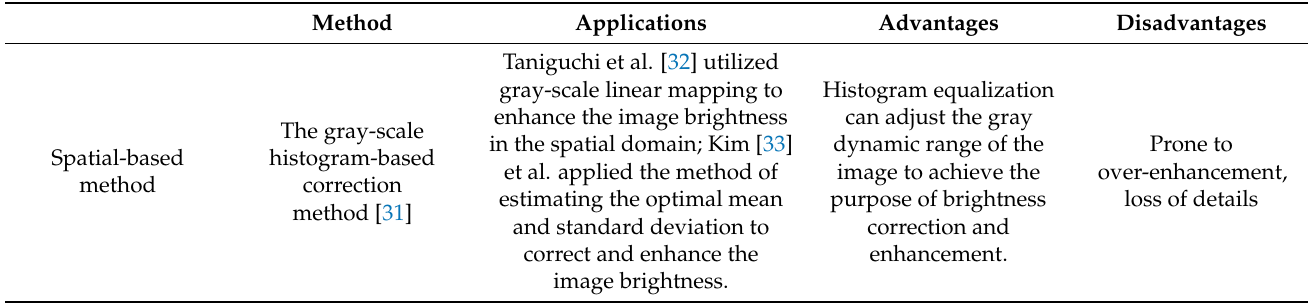
Table 3. Methods based on the spatial and frequency